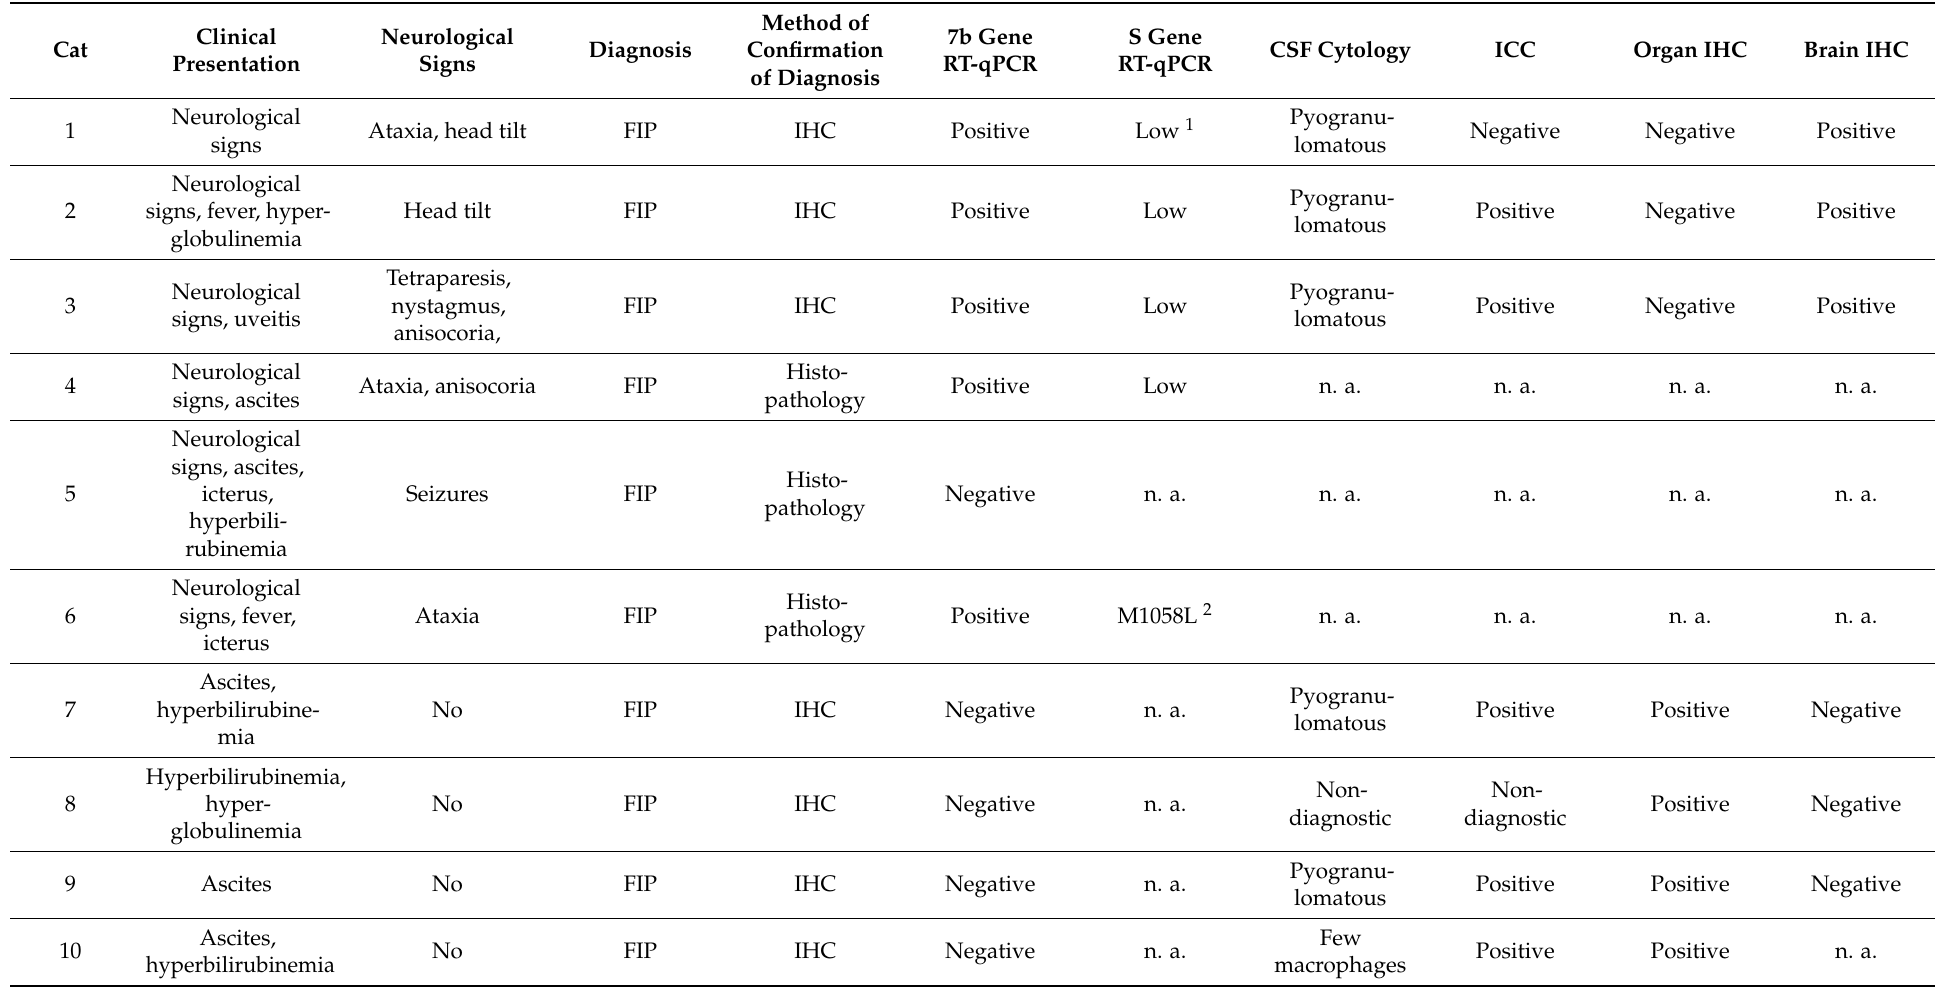
Table 1. Details of cats diagnosed with feline infectious peritonitis (FIP): clinical and/or laboratory signs upon presentation leading to inclusion, details of neurological signs, if present, final diagnosis and method of confirmation, results of the 7b and spike (S) gene realtime reverse transcriptase polymerase chain reactions (RT-qPCR), results of cerebrospinal fluid